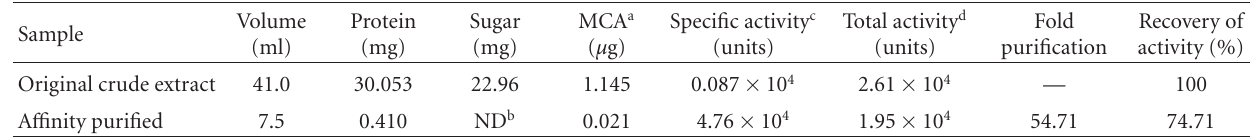
Table 1: Purification of CSL from mycelial extract.